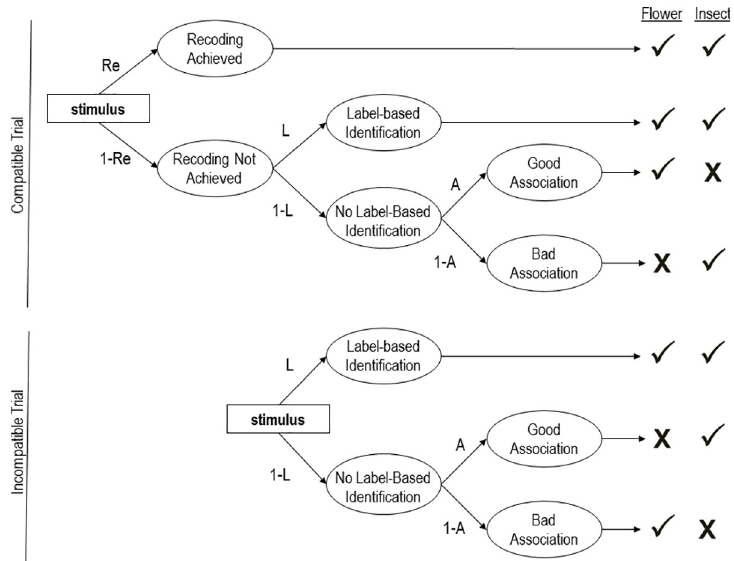
Fig 1. The ReAL model depicted for an IAT with flowers and insects as target categories. The figure illustrates how Recoding ( Re) , evaluative associations ( A ), and label-based identification ( L ) jointly produce correct ( ✓ ) and incorrect ( X ) responses on compatible and incompatible